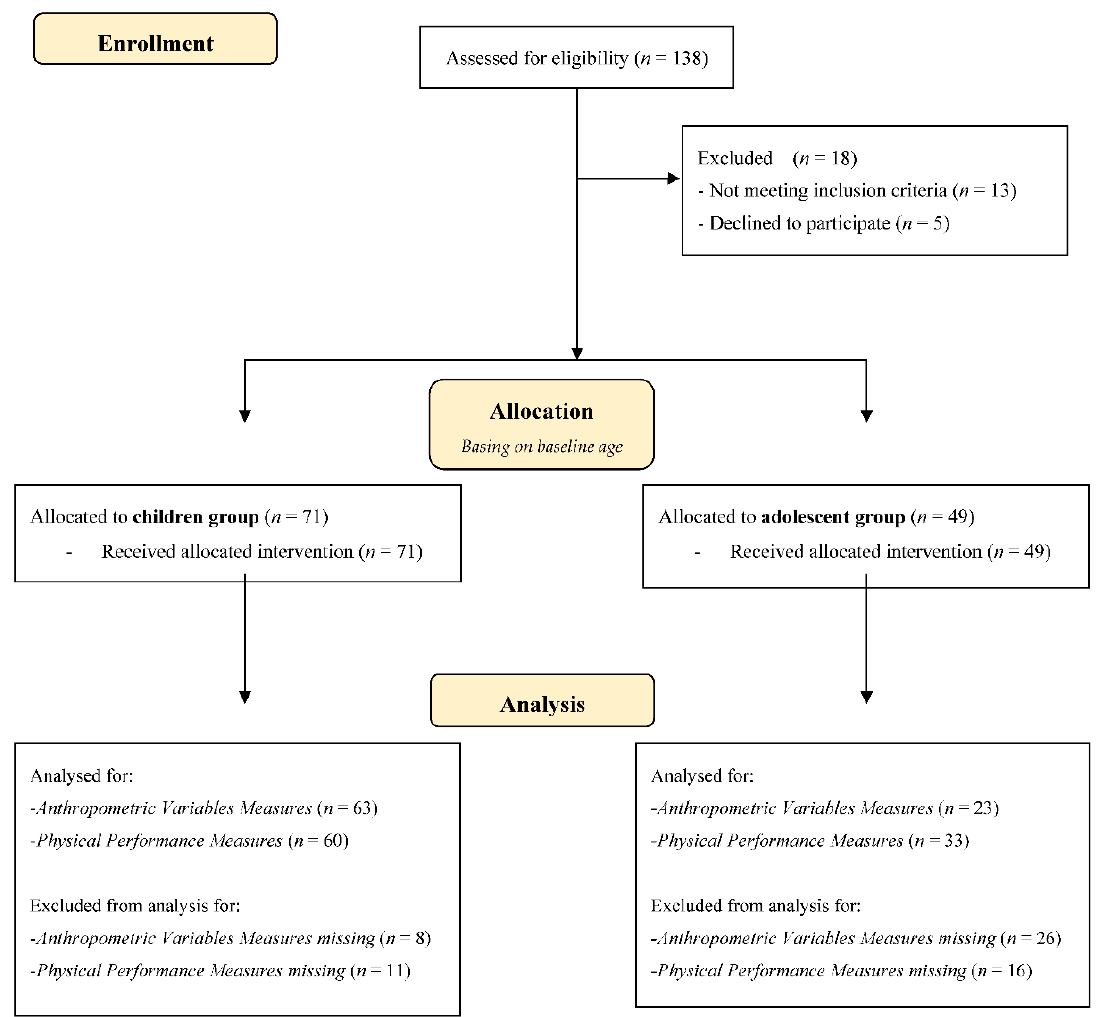
Figure 1. CONSORT 2010 Flow Diagram. Table 1. Anthropometric and Physical Performance measures baseline values in children and ado- lescent groups. Data are presented as mean (Mn) ± Standard Deviation (SD) values. Statistical significance was set for p values ≤ 0.05.